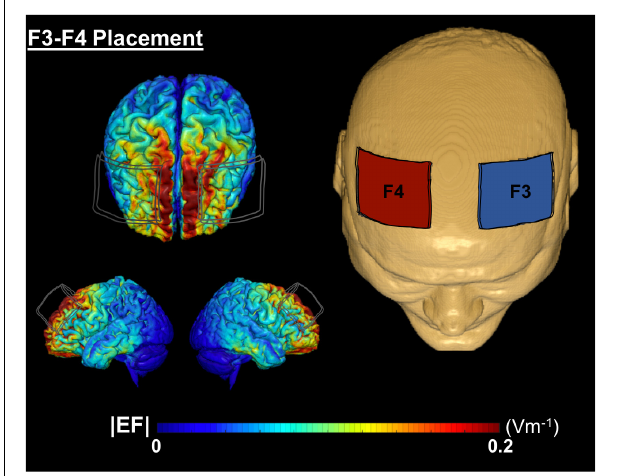
FIGURE 2 | A computational model of electric field distribution for F3–F4 placement in one participant. The left hand side depicts the electric field strengths (|EF|) on the cortical surface for F3 (cathode, blue electrode) and F4 (anode, red electrode) montage. |EF| distribution was calculated using a finite element based approach in ROAST (Huang et al.,